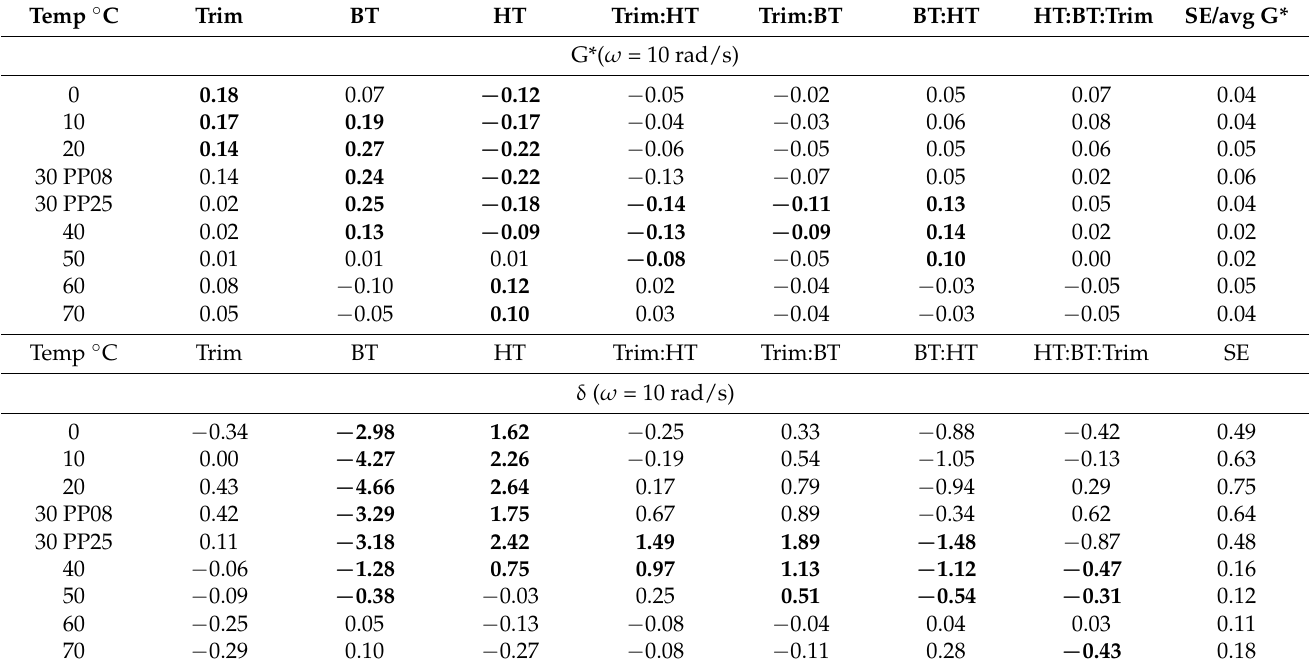
Table 8. Effect estimates and Standard Errors (SE) for 160/220_I. The significant effects with a 95% confidence interval are shown in bold.